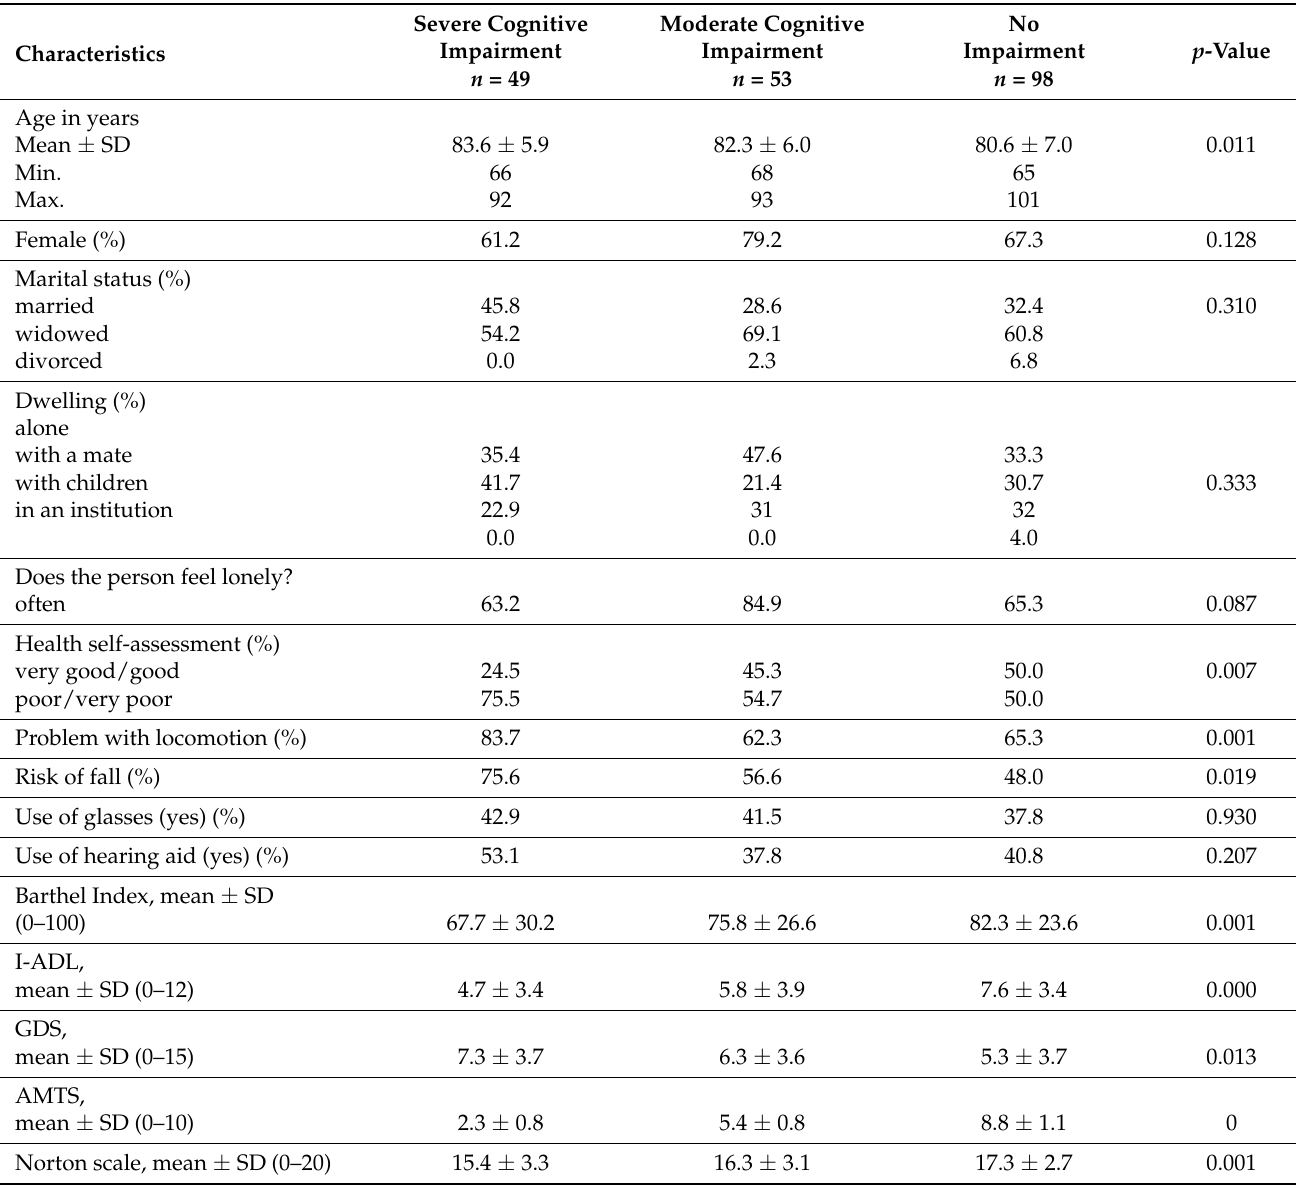
Table 1. Socio-demographic characteristics and the results of functional status assessment in different cognitive function groups ( n =